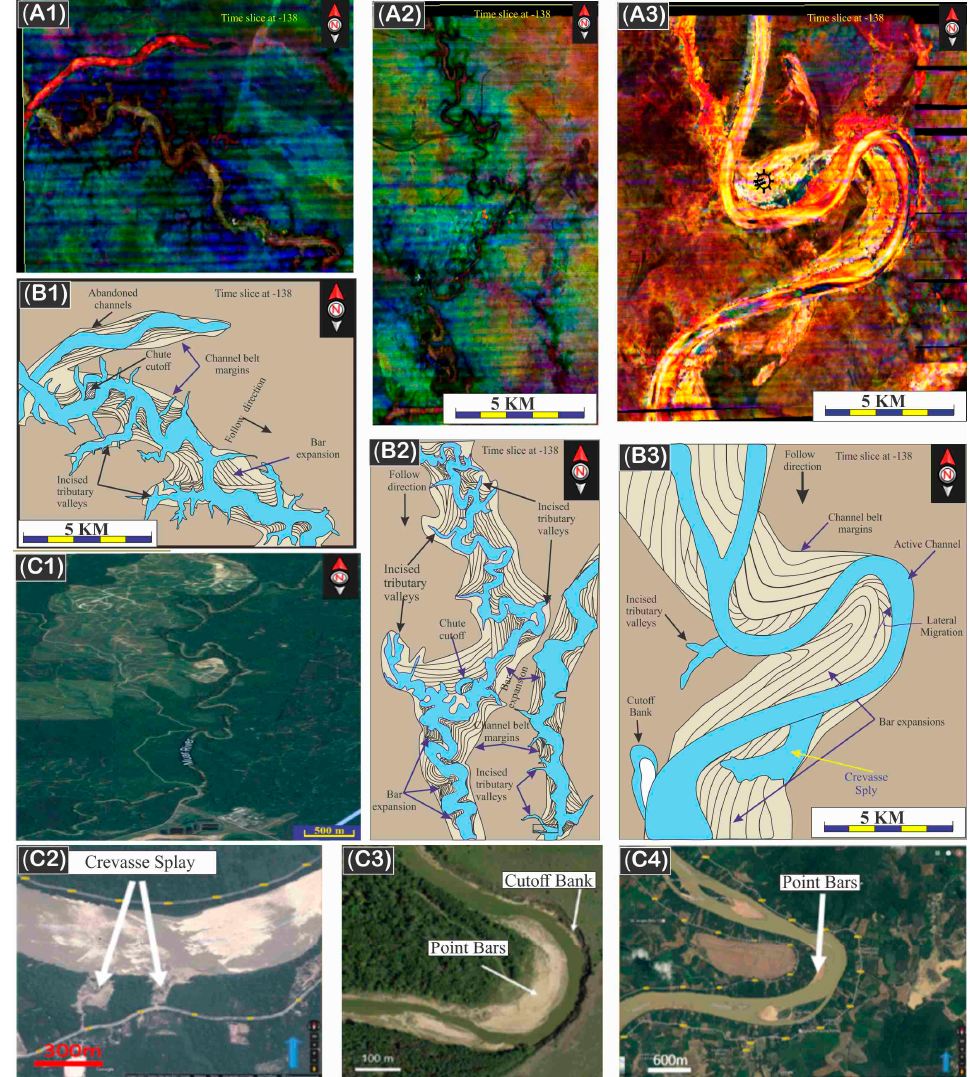
Figure 6. The map-view slides of continental channel belts and channels prominent at − 138 ms. Slides ( A1 – A3 ) represent the time slices of RGB color blending seismic attribute at two way travel time (TWT) 138 ms, while ( B1 ) shows a map-view representing the major geomorphological and depositional features of the southwest part of the studied area. Slide ( B2 ) represents the meandering middle channels extended from the north to south, with the delineation of geomorphological elements. Slide ( B3 ) shows the major sinuous channel at − 138 ms. Satellite images in figures ( C1 – C4 ) reveal a recent analog with comparable features and similar depositional features, Muar River, Johor, Negeri Sembilan Pahang in